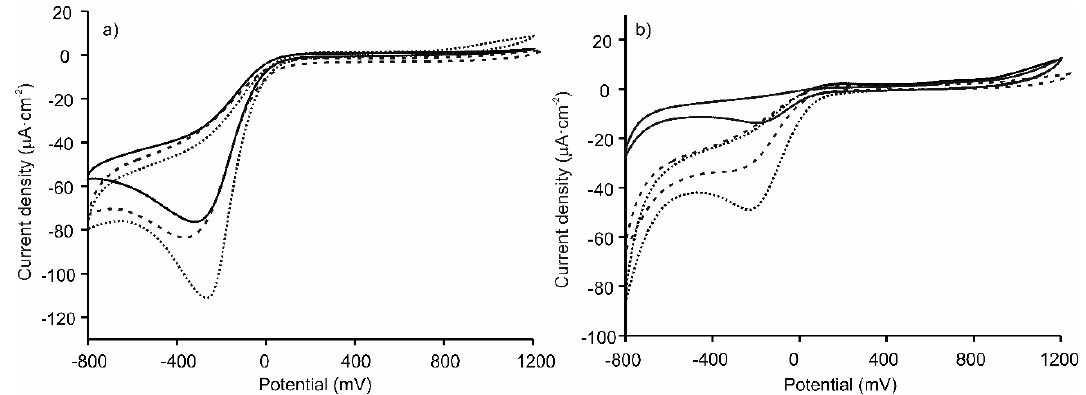
Figure 4. Voltammetric response of catechol 10-4 M in 0.01 M phosphate buffer pH 7 at an a) ITO-Tyr (solid line), [(CHI)-(CuPcS)-(CHI)-( AuNPs)] 2 -Tyr (dashed line), [(CHI)-(AuNPs)-(CHI)-(CuPcS)] 2 -Tyr (dotted line); and b) ITO-Lac (solid line), [(CHI)-(CuPcS)-(CHI)-(AuNPs)] 2 -Lac (dashed line), [(CHI)-(AuNPs)-(CHI)-(CuPcS)] 2 -Lac (dotted line).